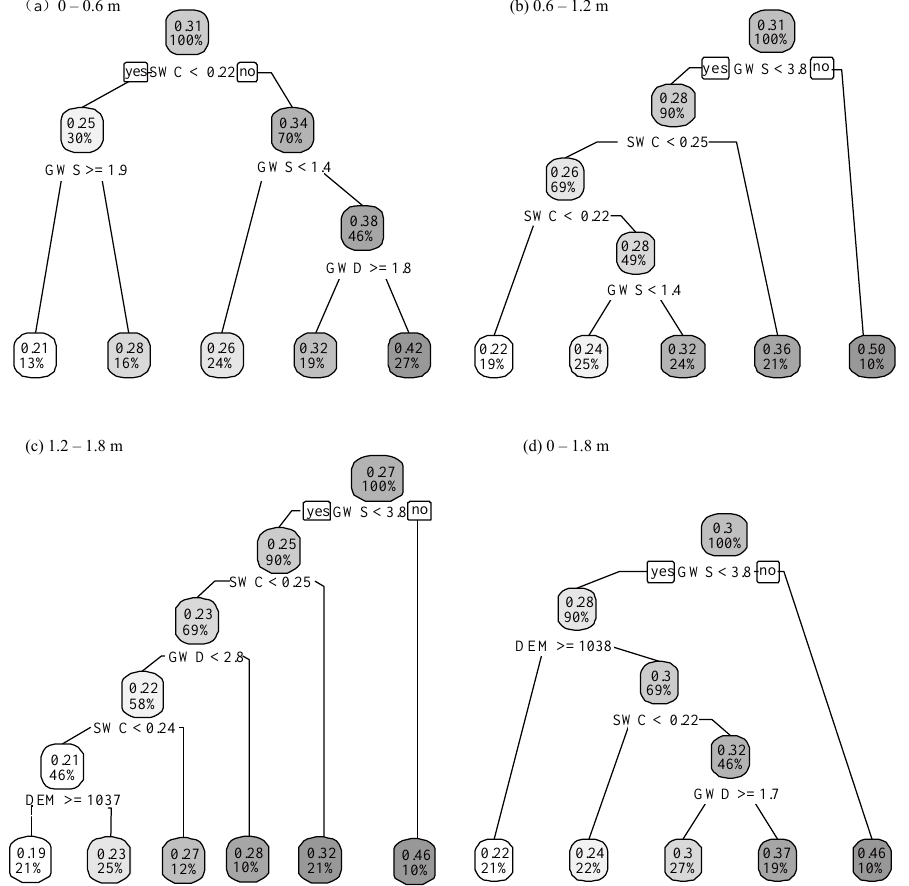
Figure 8. Regression trees for soil salinity at depths of ( a ) 0–0.6 m, ( b ) 0.6–1.2 m, ( c ) 1.2–1.8 m, and ( d ) 0–1.8 m. The top number in the boxes is the mean soil salinity, and the bottom number denotes the percentage of soil salinity samples belonging to subsets in the total numbers. The environmental factors were groundwater table depth (GWD), groundwater salinity (GWS), soil texture represented by soil water content (SWC), and digital elevation model (DEM). Table 3. Pearson’s correlation matrix between soil salinity and environmental variables.